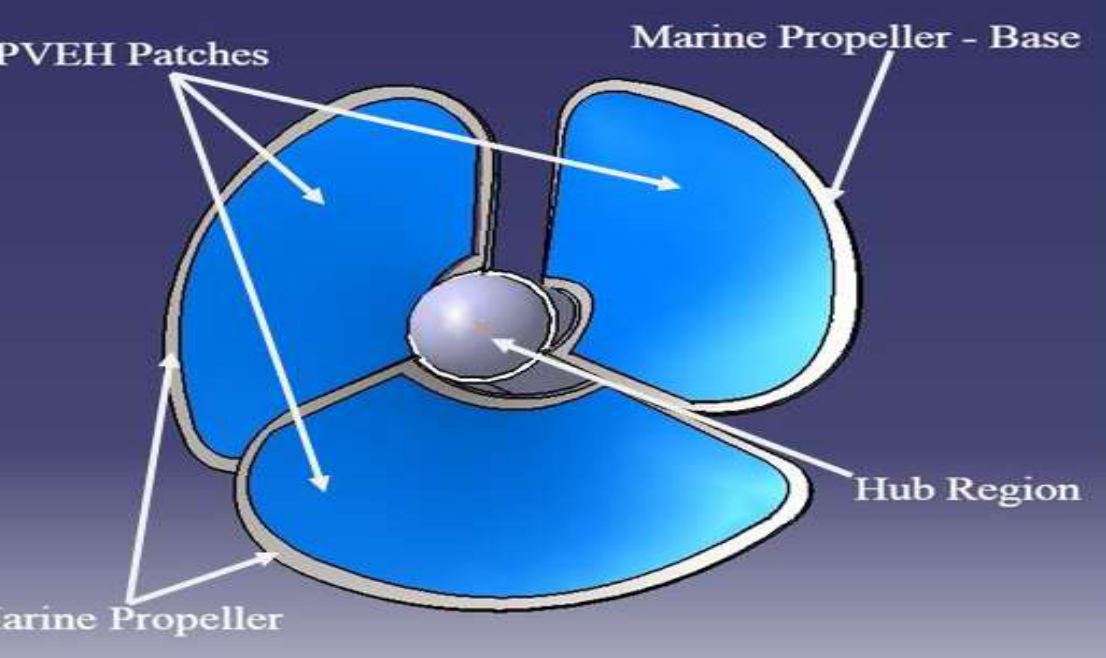
Figure 51. PVEH Patches adopted Hydro Rotor—Front Side View.